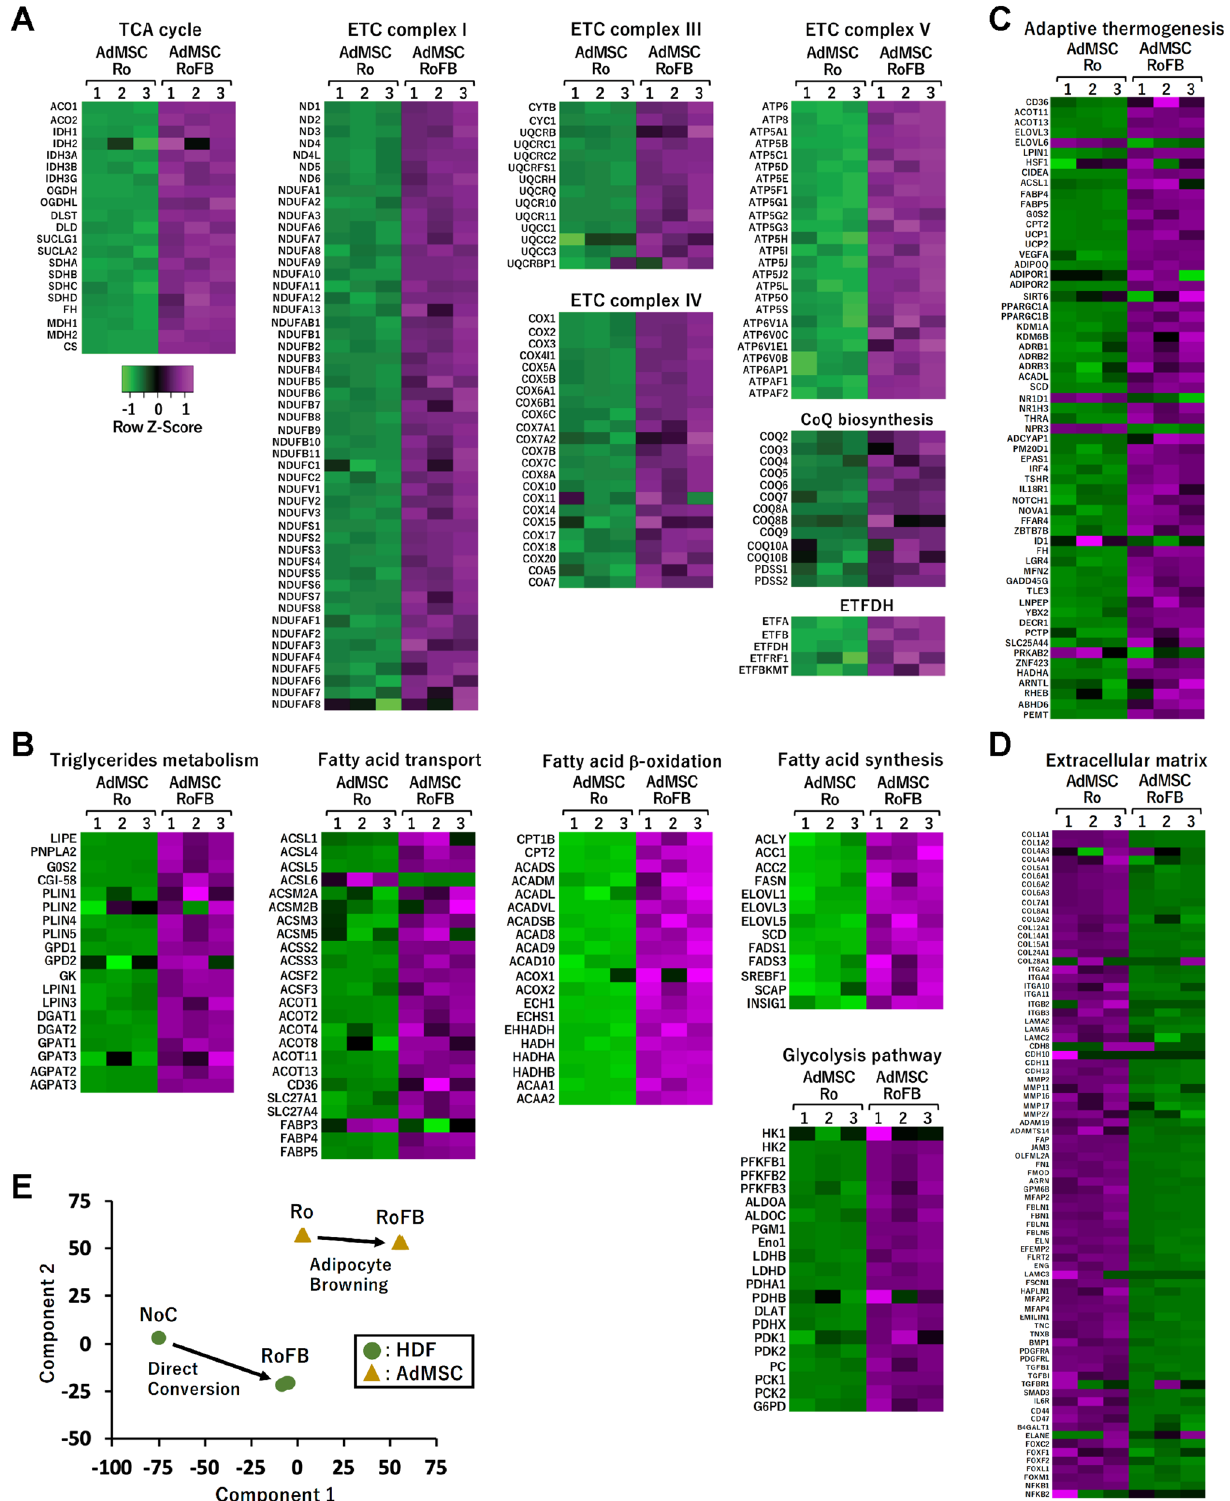
Figure 5. Heat map analysis of transcriptional profiles in AdMSC-derived adipocytes. ( A–D ) The transcriptional profiles between AdMSC-Ro and AdMSC-RoFB are shown as heat maps in the same set of genes as shown in Fig. 2. The color scale shows z-scored FPKM representing mRNA levels of each gene in green (lower expression) and magenta (higher expression). ( E ) Multidimensional scaling analysis graphically indicates the similarity and variability of total expression patterns of HDF- and AdMSC-derived samples as